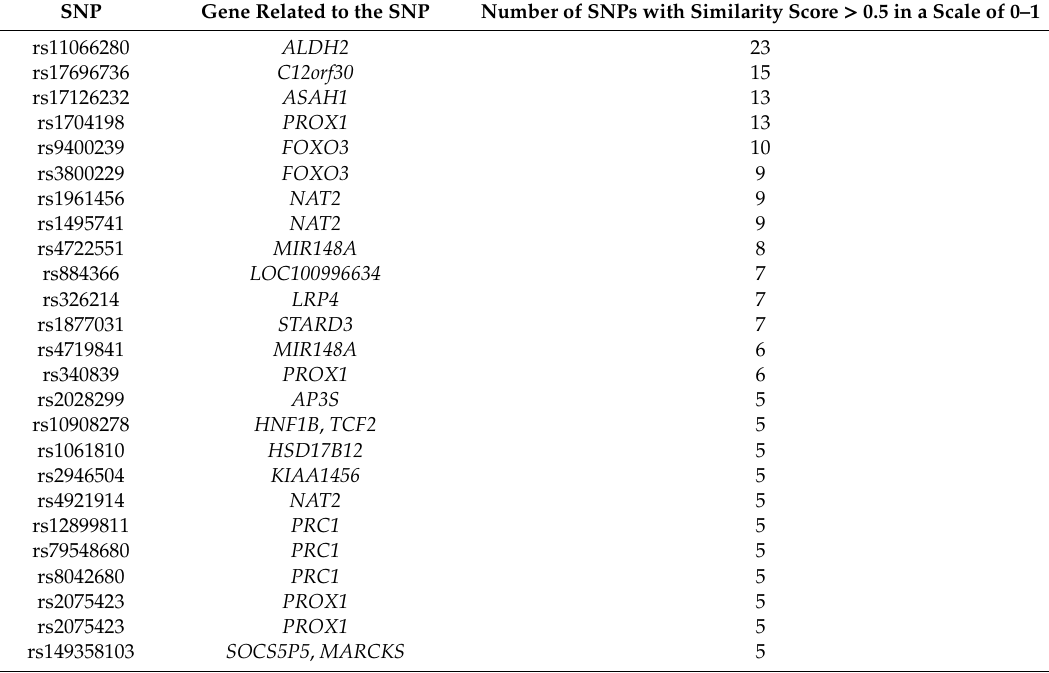
Table 4. List of identified SNPs with related genes that showed similarity to each other using the Socialiser tool.